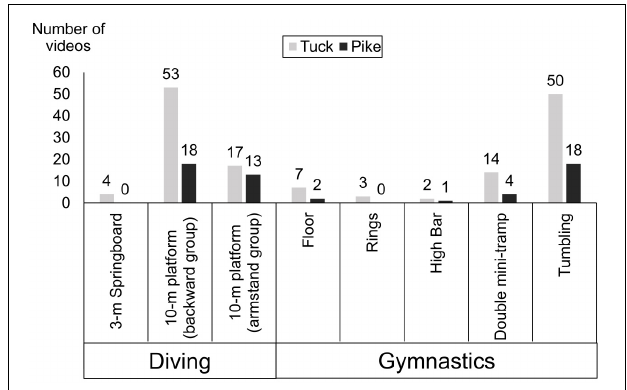
FIGURE 3 | Number of tuck and pike multiple (3.0 or 3.5) back somersault moves in competitive diving ( n = 105) and gymnastics ( n = 101) videos retrieved in years 2016–2021 (total = 206